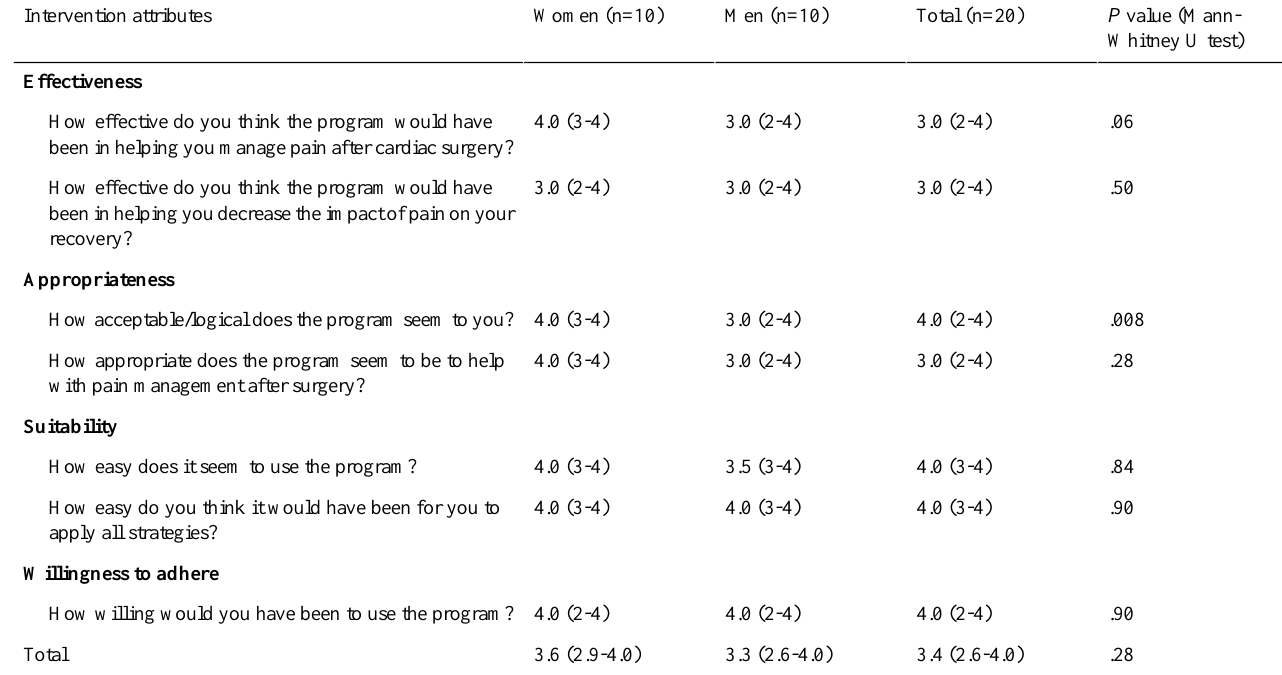
Table 5. Median (minimum-maximum) of ratings for intervention attributes according to the TAP